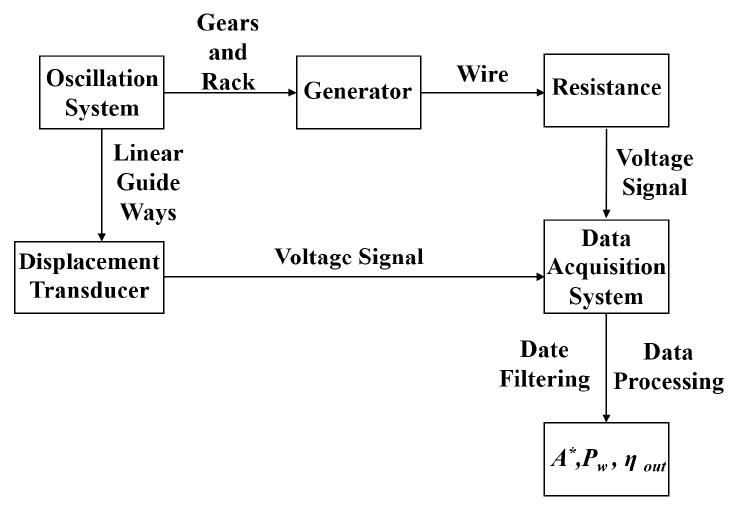
Figure 7. Test flow chart.